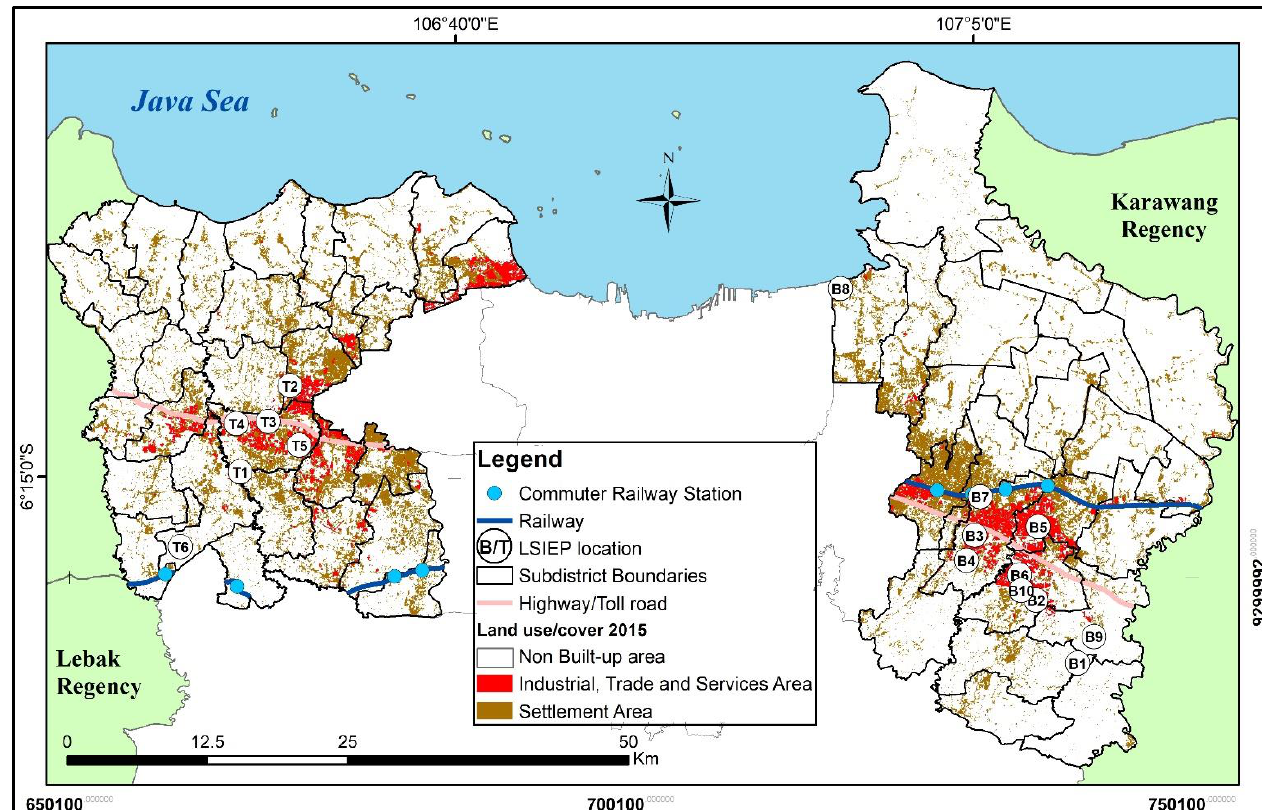
Figure 6. The distribution of LSIEP and the built-up area in 2015.